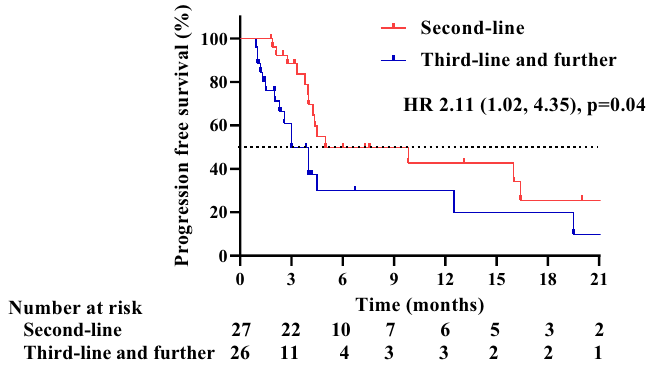
Figure 3. In univariable analysis, comparison of PFS between patients treated with apatinib as the second- line medication with the third-line and further line medication. The median PFS was 5.0 months (95% CI 0.00–11.82) for treatment with apatinib as the second-line medication versus 3.0 months (95% CI 1.68–4.32) for treatment with apatinib as the third-line and further line medication (p =